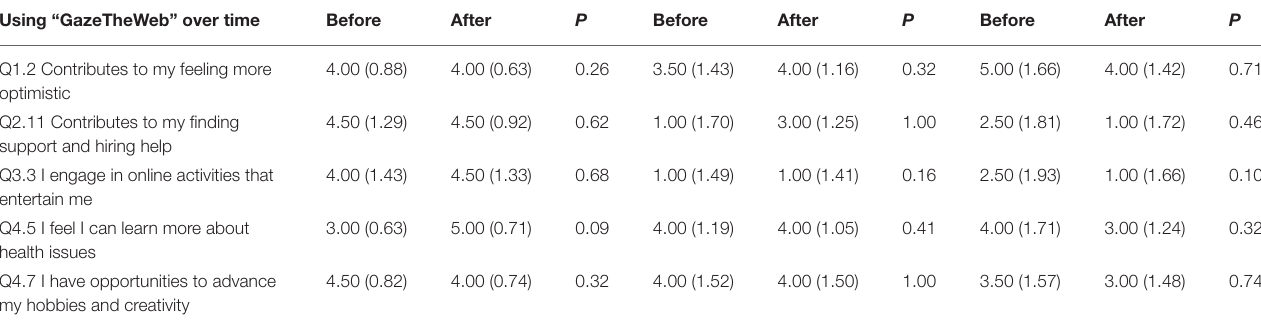
TABLE 7 | Descriptive statistics (median and standard deviation) for answers to the well being indicator questions and comparison using Wilcoxon non-parametric statistical test. Using “GazeTheWeb” over time Before After P Before After P Before After